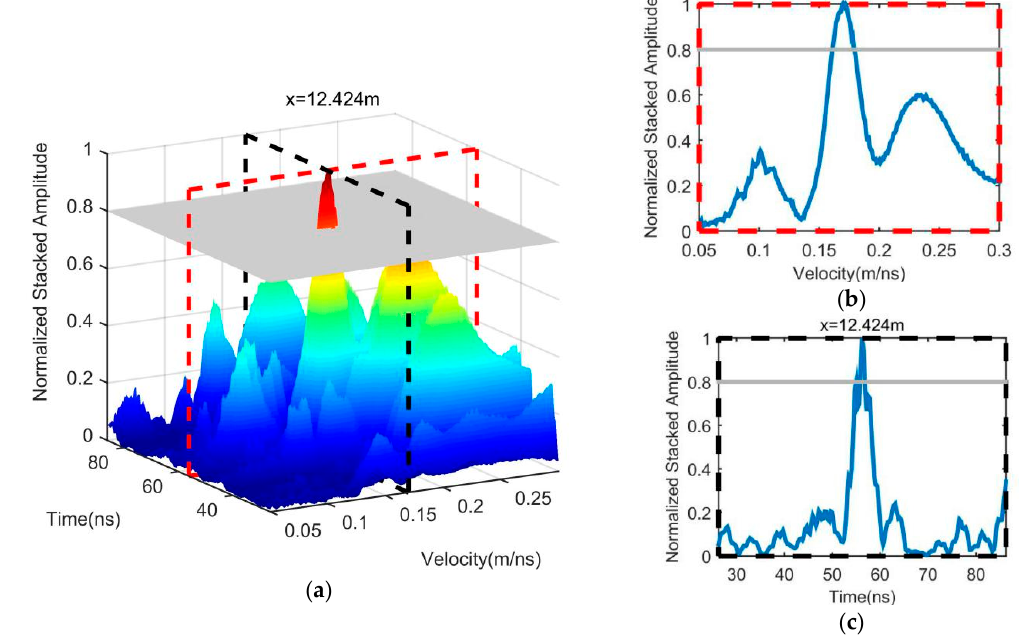
Figure 15. Error computation. ( a ) 3D surface plot of the first slice in Figure 8b. ( b ) The profile of in the red rectangle of ( a ). ( c ) The profile of in the black rectangle of ( a